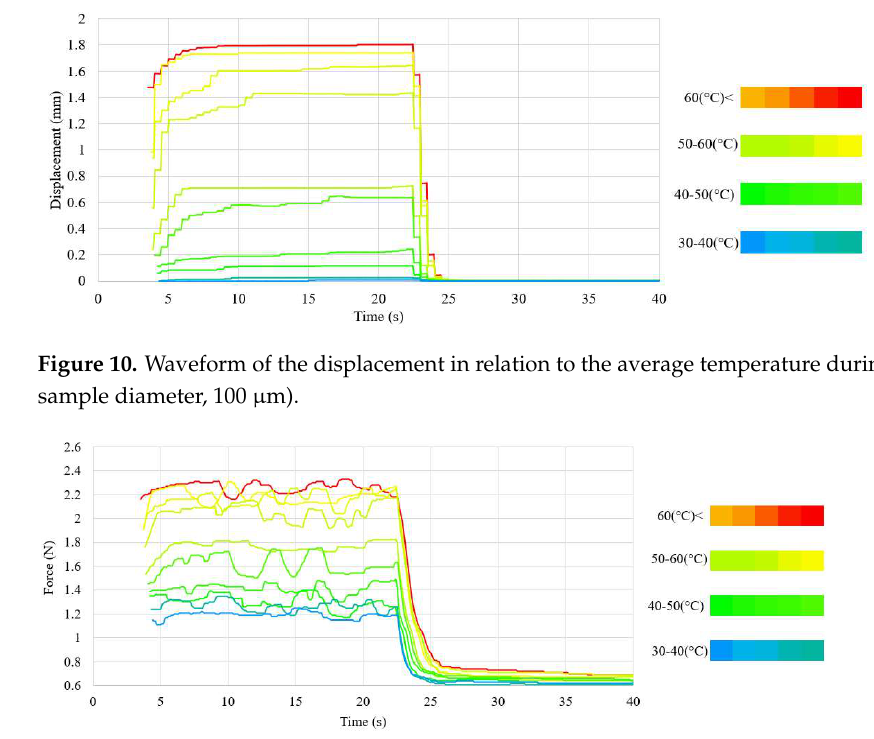
Figure 11. Waveform of the force in relation to the average temperature during heating (test sample diameter, 100 μm).